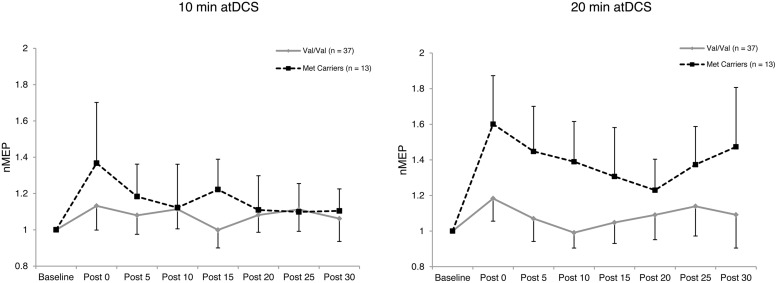
Temporal pattern of post-stimulation response for each atDCS session and BDNF genotype. Normalized MEP amplitude (ordinate) plotted for each atDCS duration (left panel – 10 min atDCS; right panel – 20 min atDCS) across all post stimulation time points (abscissa) for each brain derived neurotrophic factor (BDNF) genotype group (Val/Val group – solid line with diamond markers; Met carriers – dashed line with square markers). nMEP > 1 represents facilitation, nMEP < 1 indicates suppression. Error bars display the 95% confidence interval around the mean in one direction.